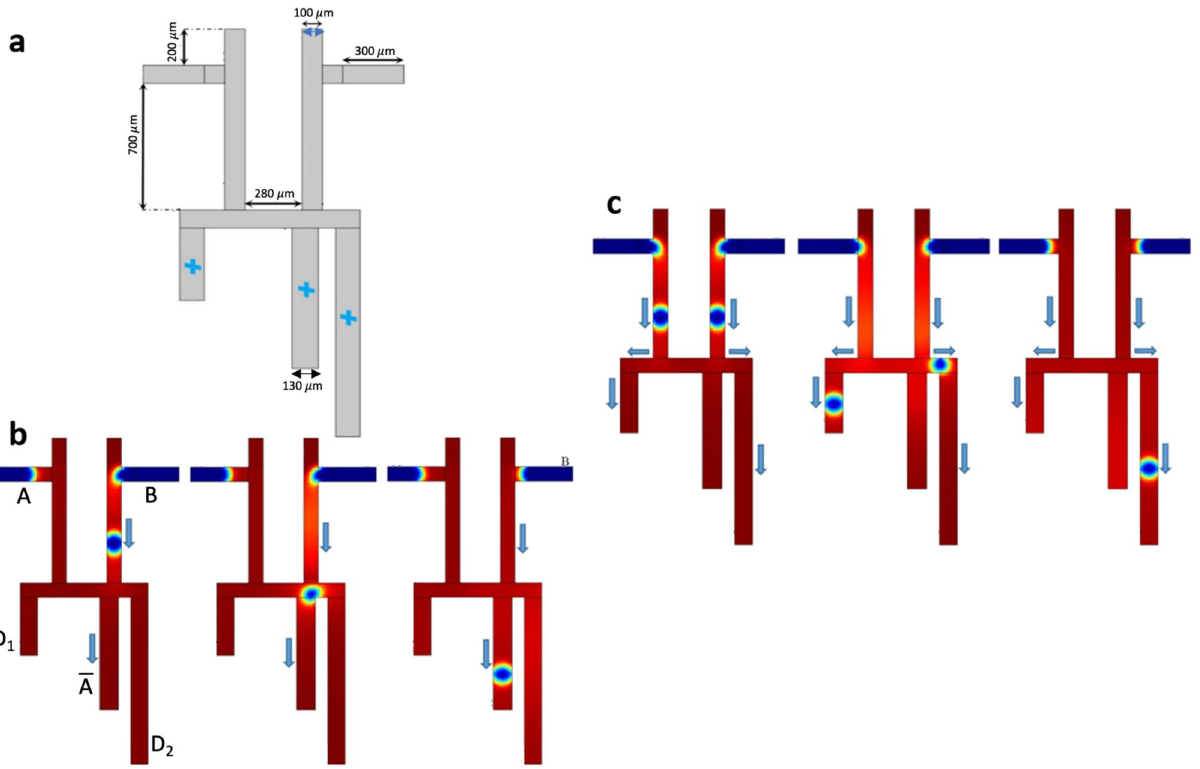
Figure 6. The microfluidic design of NOT gate type 2. ( a ) The design and geometry of NOT gate type 2 and the probe points at the outlets. ( b ) Series of snapshots for the logic condition A = 0, B = 1 , wherein the bubble flow is toward output A . ( c ) Series of snapshots for the logic condition A = 1, B = 1, wherein the bubble flow is toward outputs D 1 and D 2 .